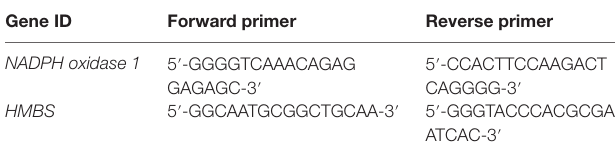
TaBle 3 | Stealth siRNAs used in transfection experiments. TaBle 2 | Primers used for